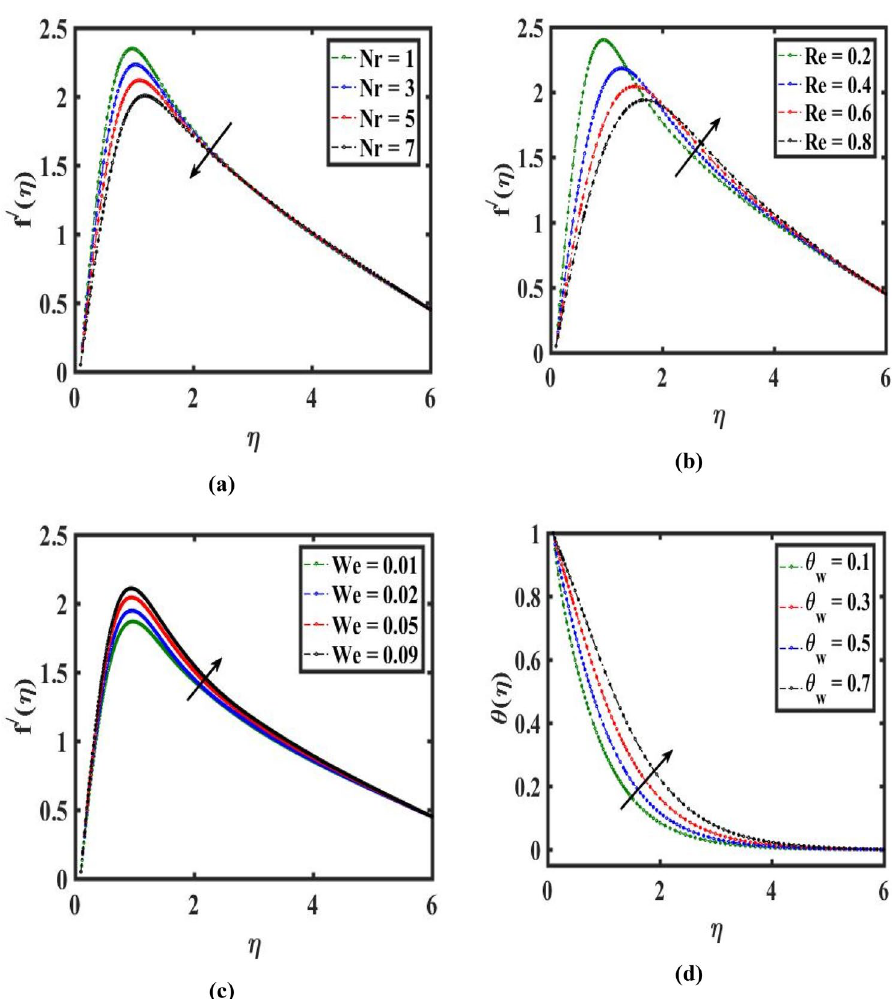
Figure 4. Impact of buoyance ratio Nr , Reynolds number Re , Weissenberg number We , and temperature ratio θ w on velocity f ′ (η) and temperature θ(η)